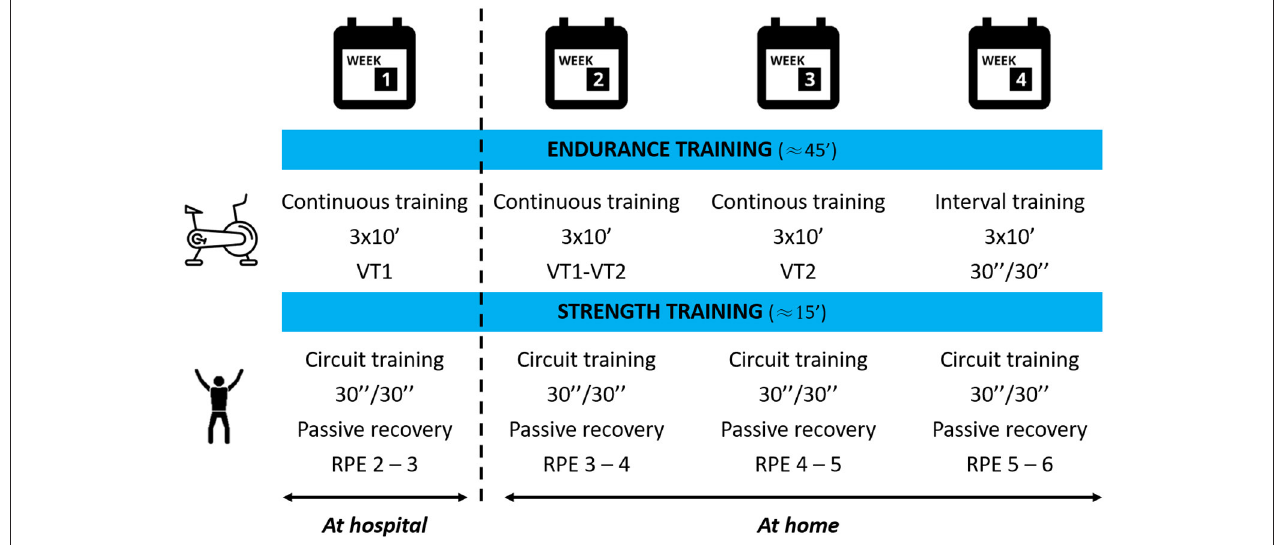
FIGURE 2 | Rehabilitation program of the CoviMouv’ study. Aerobic and resistance modalities of a 4-week training program. VT1, ventilatory threshold 1; VT2, ventilatory threshold 2; RPE, rating of perceived exertion, Borg modified scale. X”/X” corresponds to working time/recovery time.